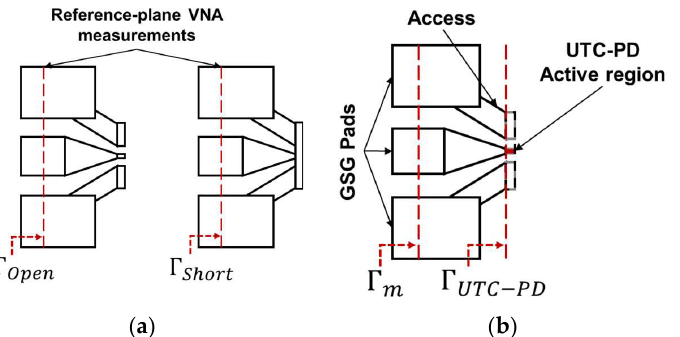
Figure 4. Schematic of: ( a ) Open and Short test structures; ( b ) schematic of the UTC-PD connected to the pads and access lines.